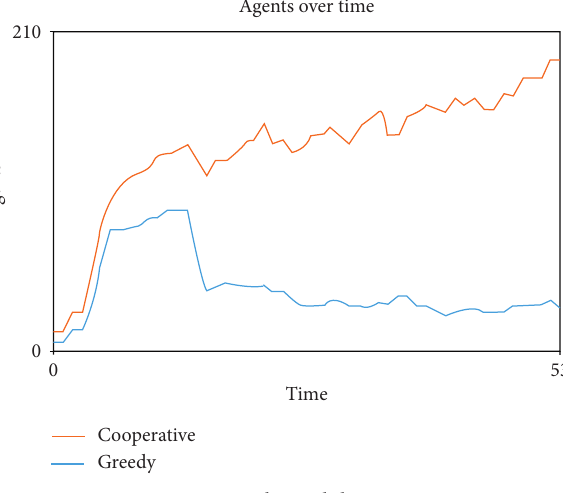
Figure 9: Matching ability � 0.03.